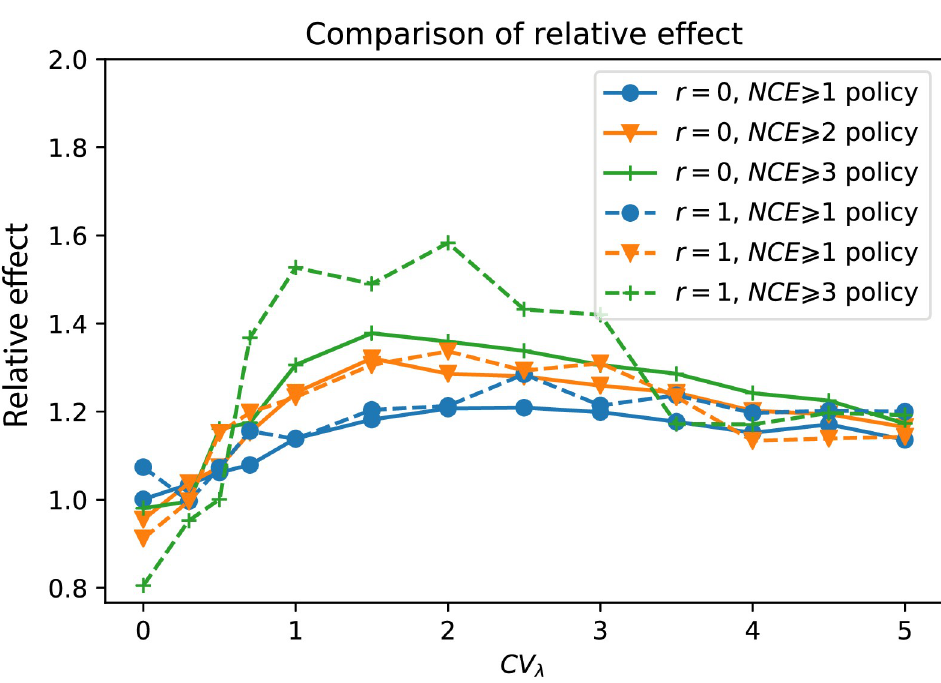
Fig 9. Comparison of the performance of NCE -based policies under the situations of with/without within-host evolutionary dynamics. Here r is the diversification rate of within-host virus population. The solid lines ( r = 0 lineage/ day) and the dashed lines ( r = 1 lineage/day) are the results with/without within-host diversity respectively. The performance of the NCE ⩾ m policy is measured by the relative effect over random prevention (please see text for definition). Three levels of threshold m are calculated: m = 1 (blue), m = 2 (orange), and m = 2 (green).